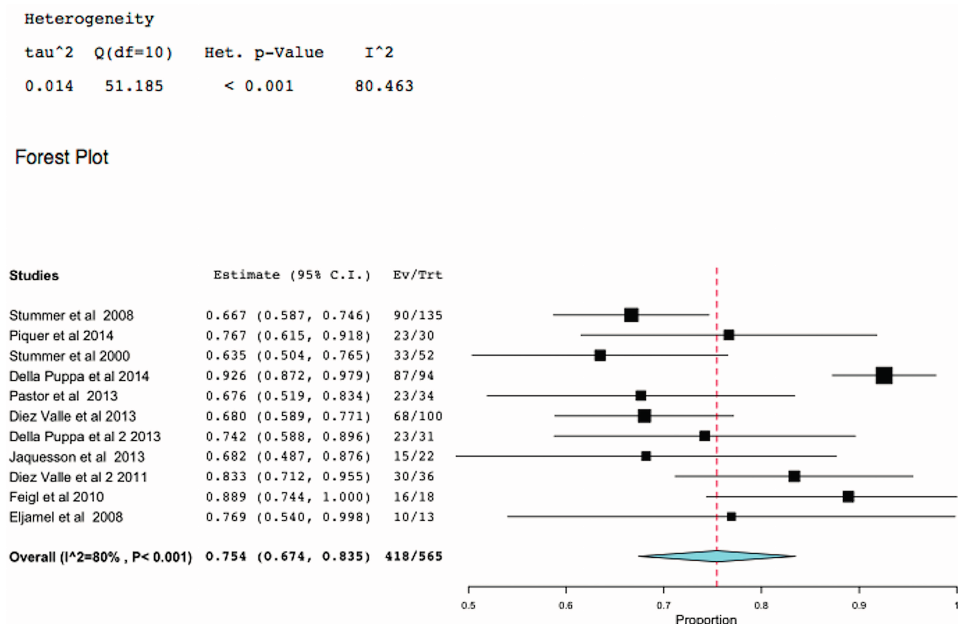
Figure 2. Meta-analysis of gross total resection (GTR) in glioblastoma multiforme